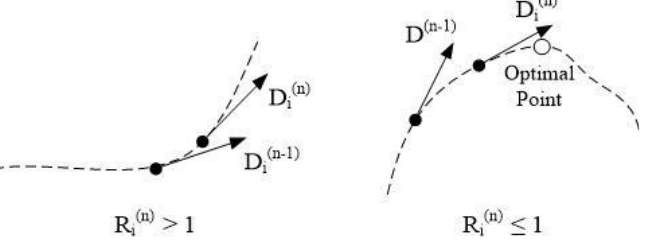
Figure 3. The adjustment of the step size is related to the ratio of the searching directions. ( n ) The step size S is adjusted based on the ratio of the searching direction ( R i ) and the i gain value ( G i )